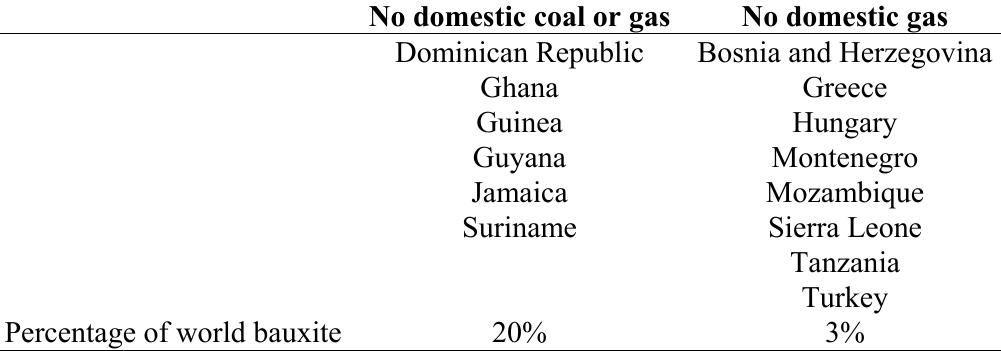
Table 7. Bauxite producing countries with no major domestic gas